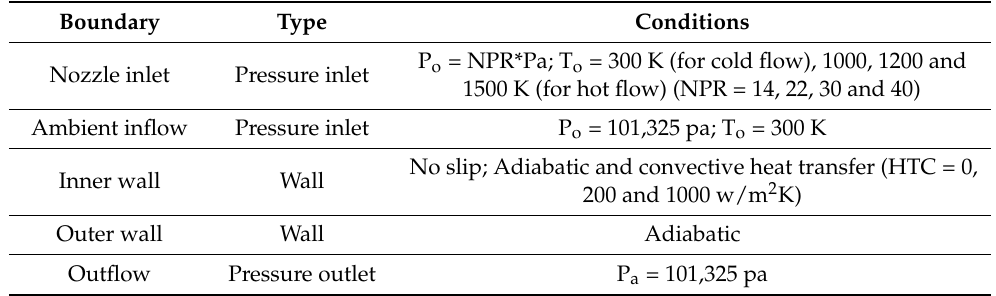
Table 4. Boundary conditions.